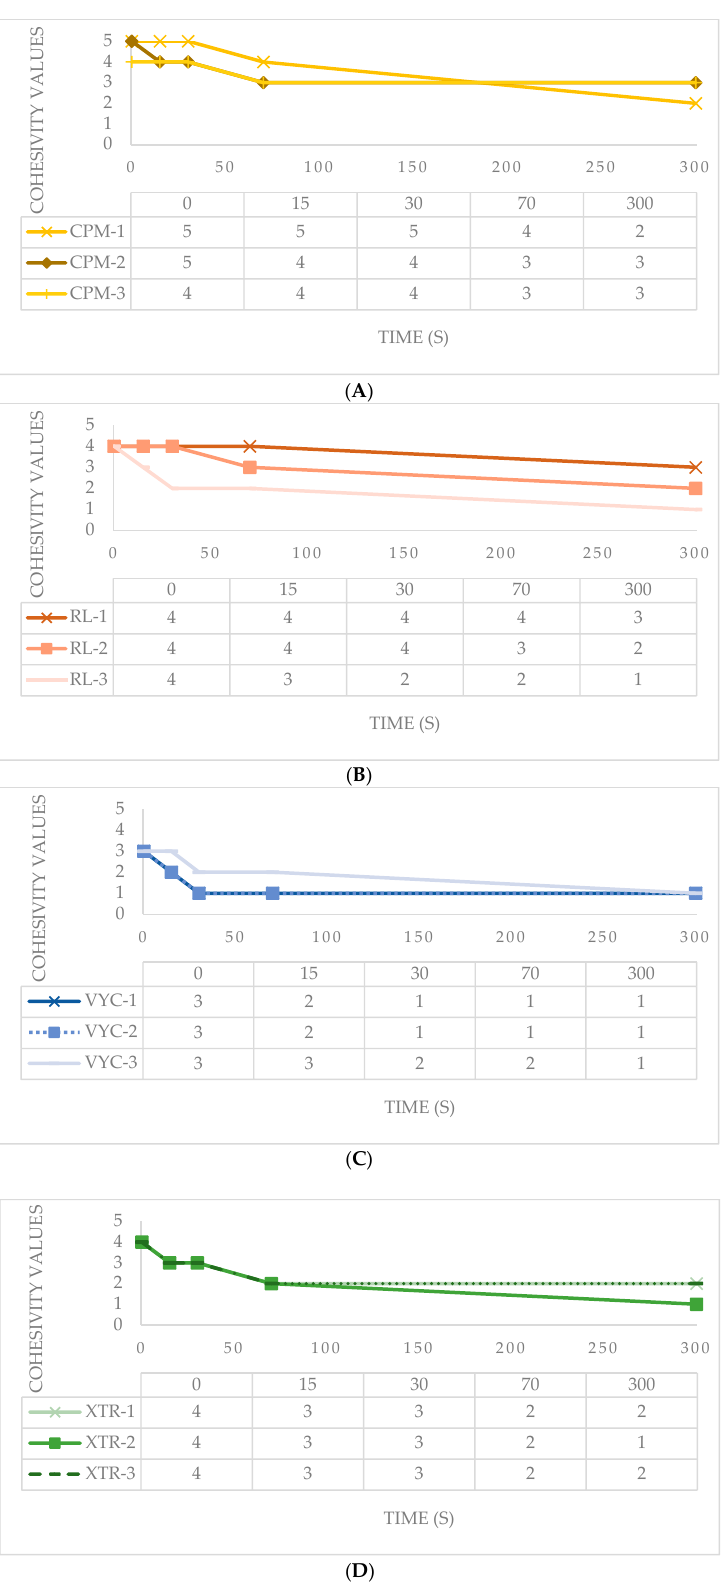
Figure 4. Gel dispersion in water at all time points for HA fillers evaluated. ( A ) CPM gels ; ( B ) RL gels ; ( C ) VYC gels ; ( D ) XTR gels .